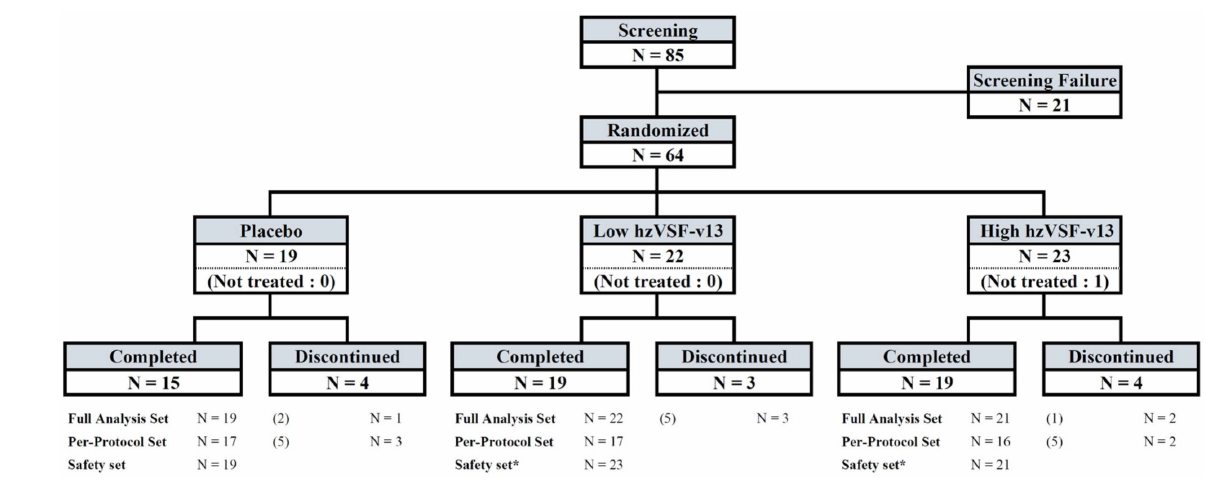
Figure 2. Patient disposition. Table 1. Demographic characteristics of the patient